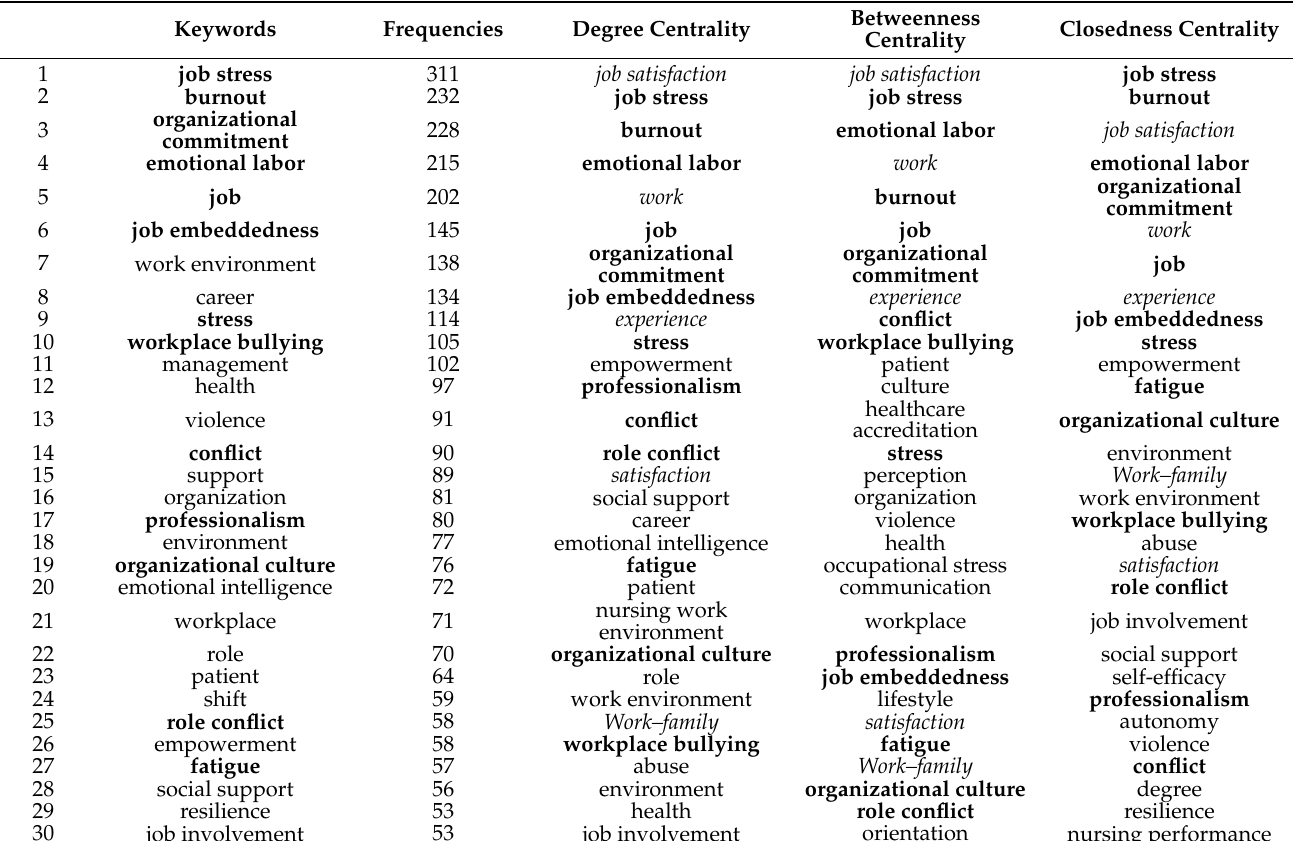
Table 2. Frequencies, Degree Centrality, Betweenness Centrality, and Closedness Centrality of the Top 30 Keywords.